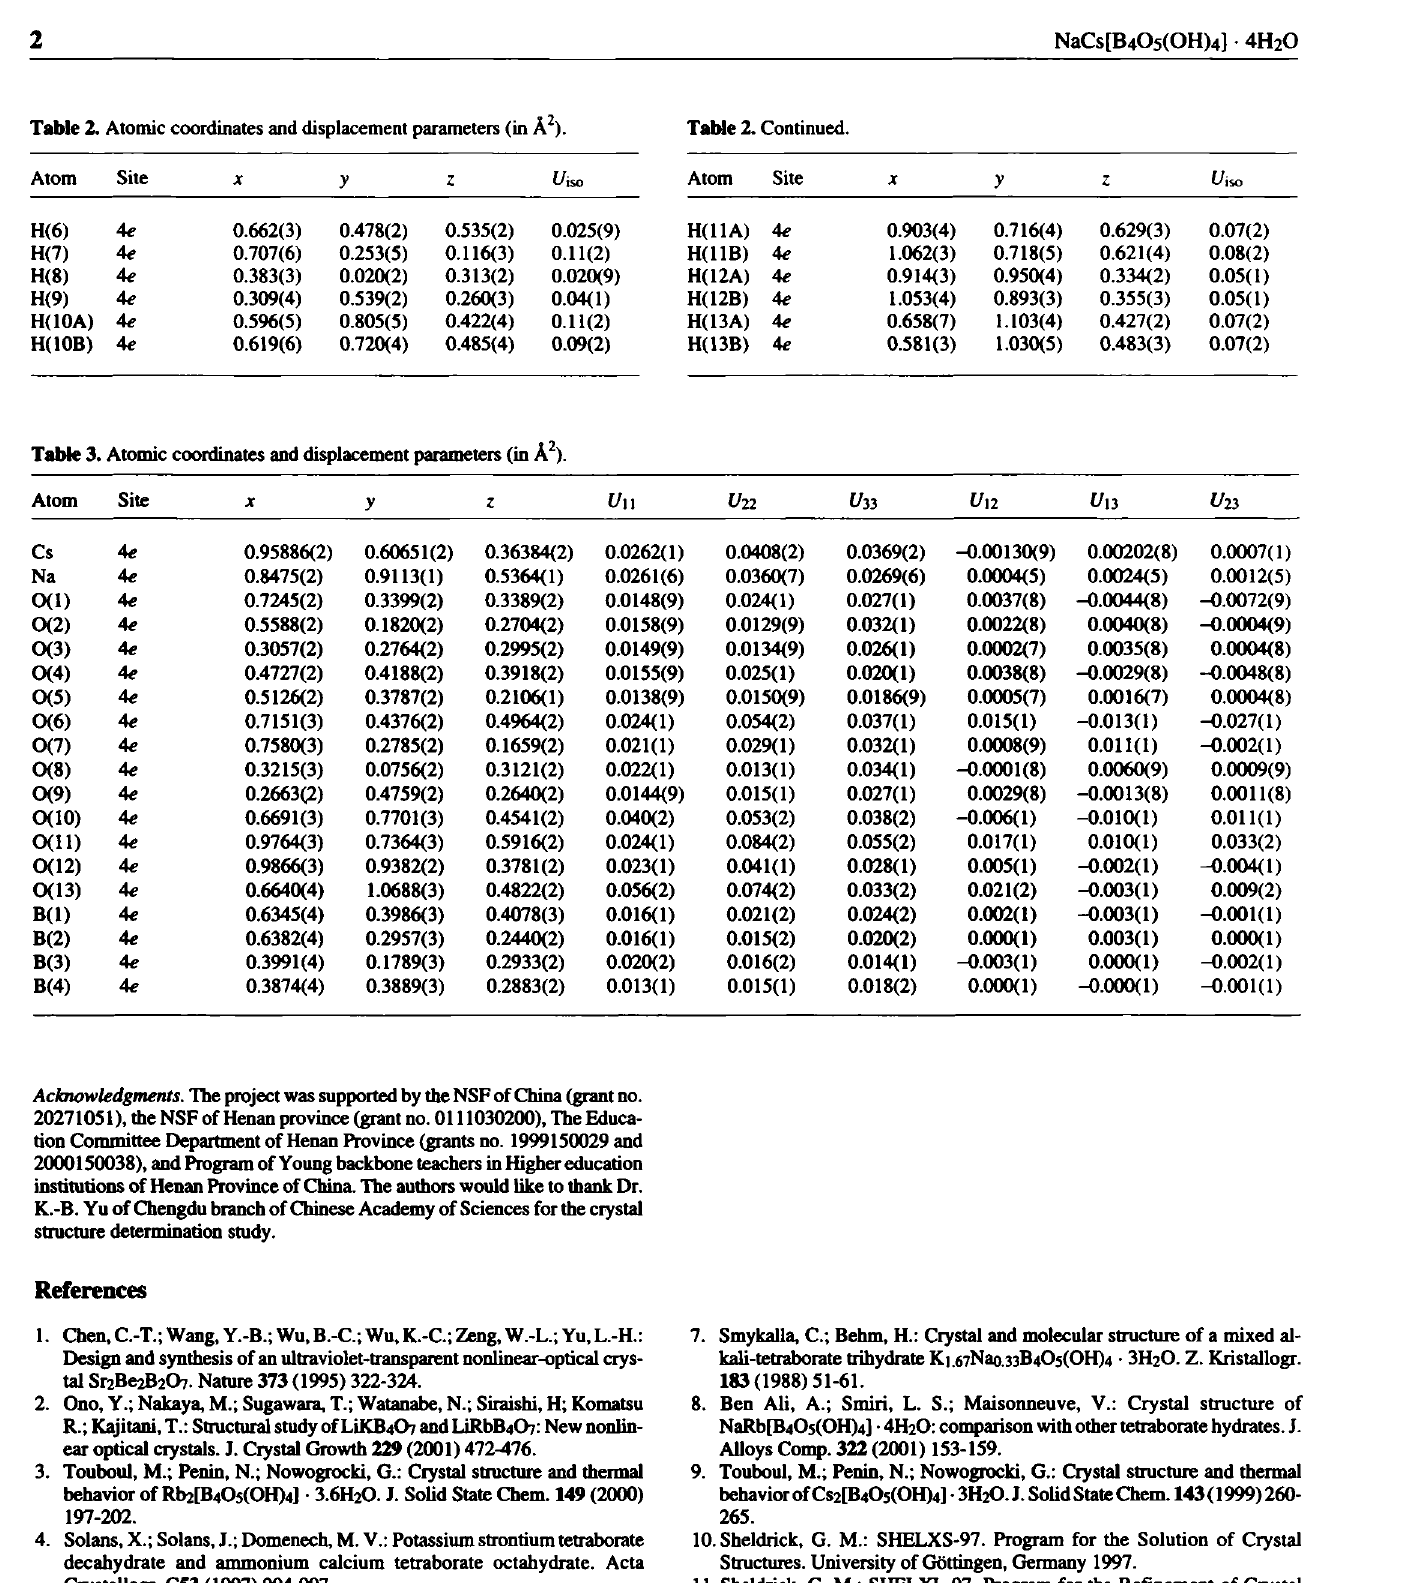
Table 2. Atomic coordinates and displacement parameters (in Â 2 ).